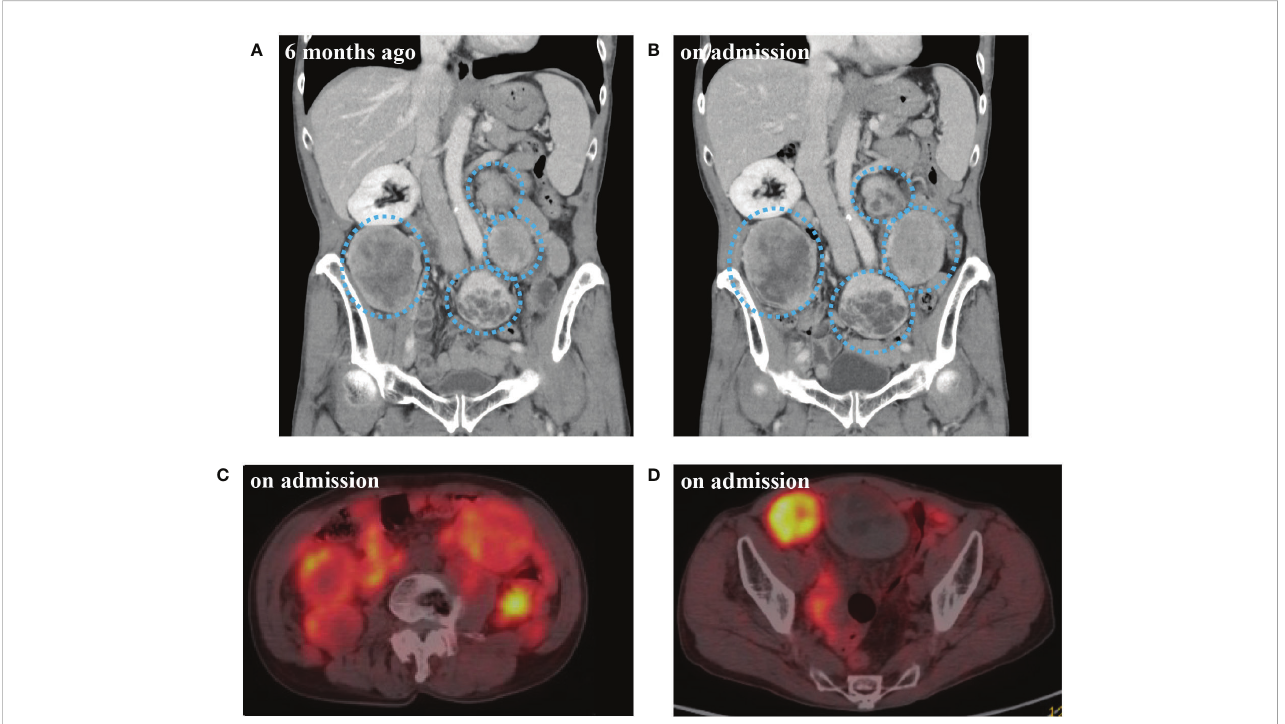
(Table 1). Moreover, no apparent hypoglycemia was found by CGM. One month after the surgery, the HbA1c level was 5.1%, and the serum IGF1 concentration was restored to the levels of normal range (Table